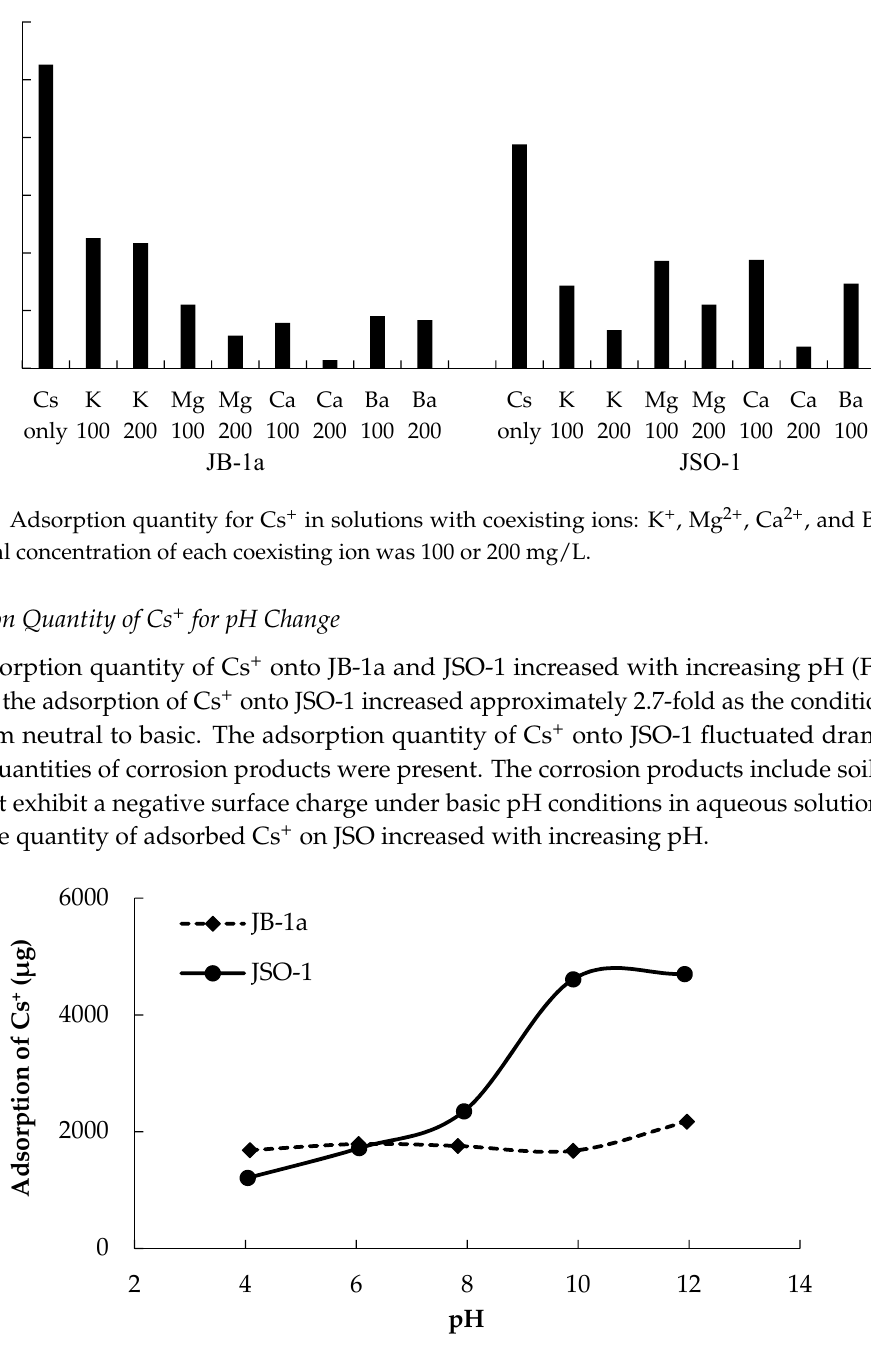
Figure 5. Effect of pH on the adsorption quantity for Cs + onto JB-1a and JSO-1 (0.5 g). Initial Cs + concentration: 200 mg/L.